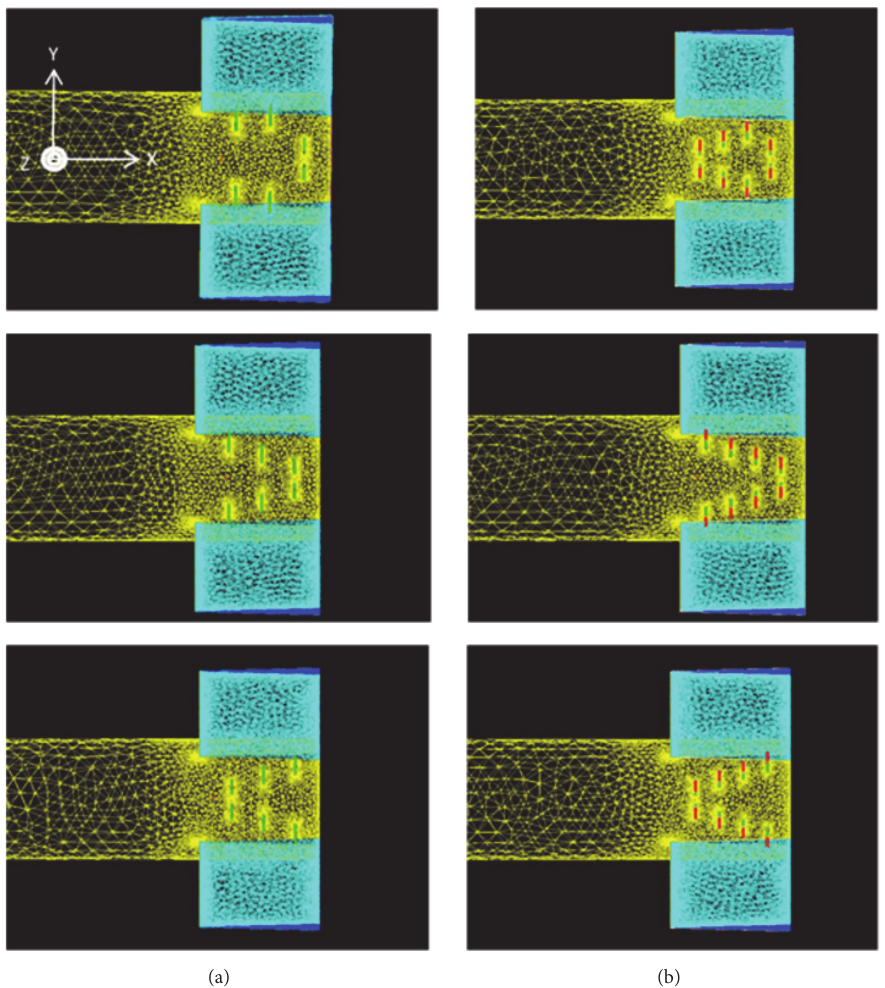
Figure 4: Computational grids with microflaps: (a) 6- and (b) 8-flap